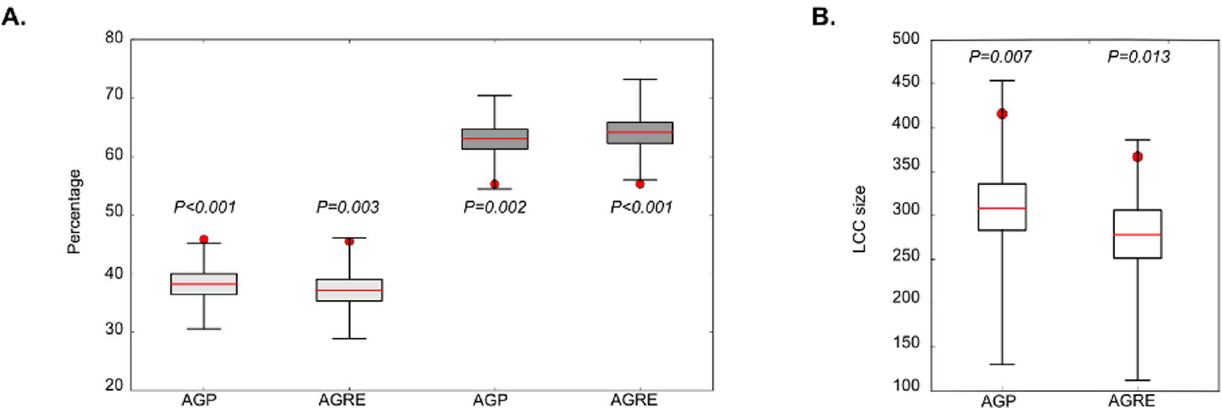
Figure 2. Network properties of proteins selected at gene-wise P , 0.1 in each ASD. a ) Comparison of percentage of direct interactions and isolated nodes between proteins selected at gene-wise P , 0.1 in each GWAS dataset (red circles) vs 1000 random samples of network proteins (represented by light gray and dark gray box plots, for direct interactions and isolated nodes, respectively). The bottom and top of the box represent the 25th and 75th percentile and the extremity of the whiskers the maximum and minimum of the random samples data. b ) Same comparison for the largest connected component (LCC) size.